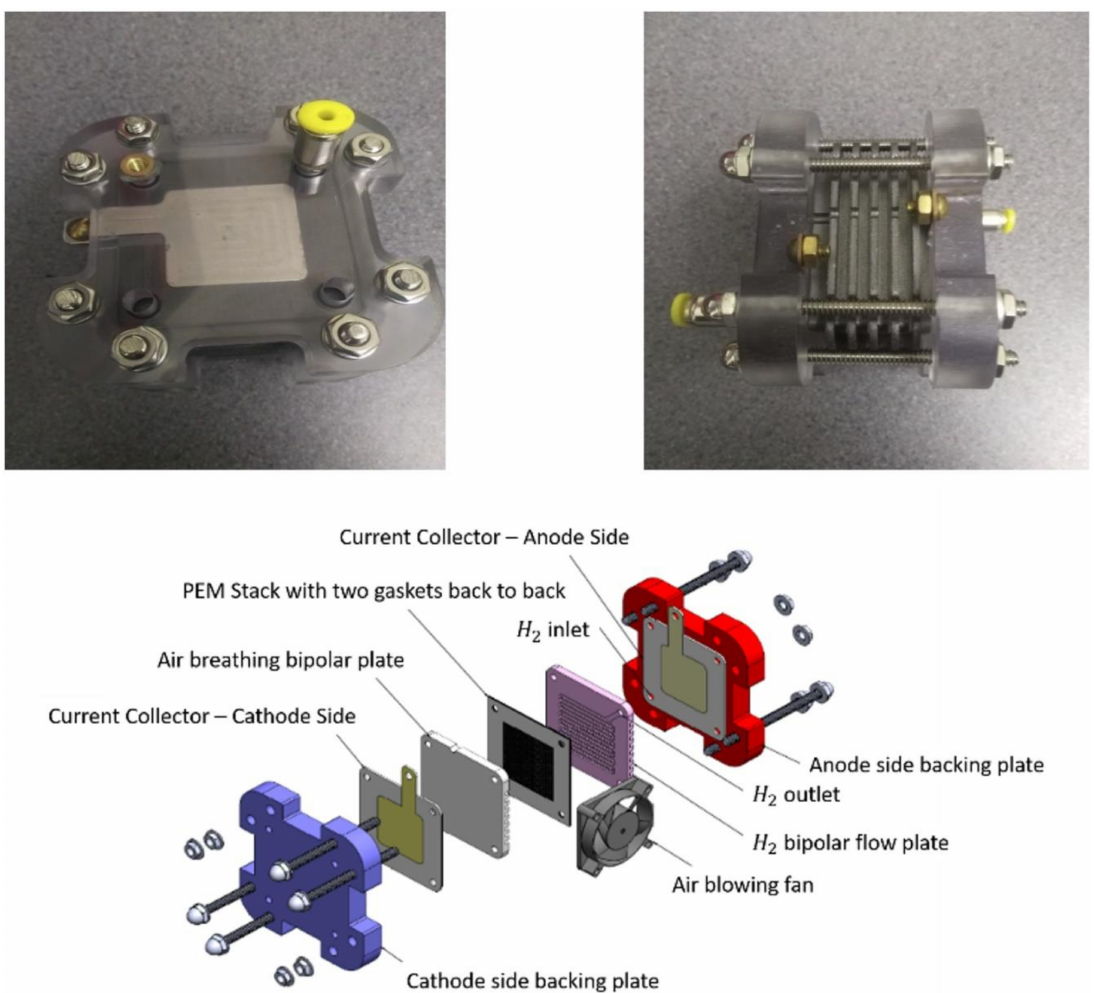
Figure 5. Exploded view of proton-exchange membrane fuel cells